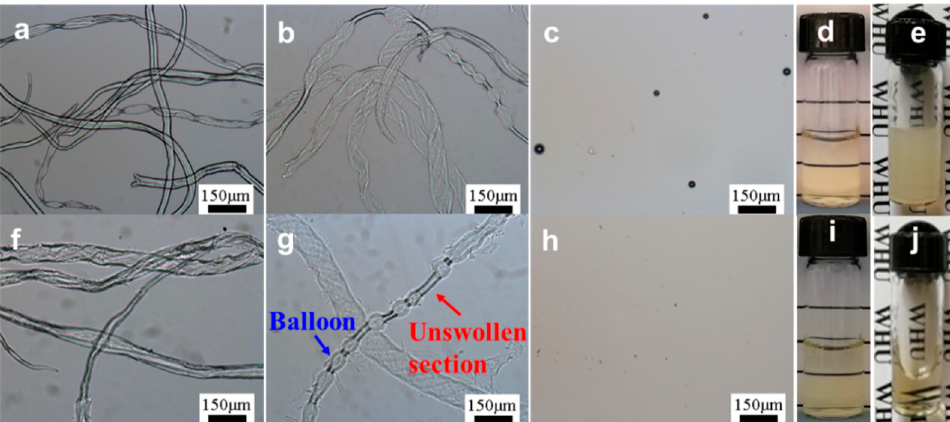
Figure 1. Optical microscopic observation of cellulose carbamate (CC) dissolving process in ( a – e ) 7 wt% NaOH and ( f – j ) 7 wt% NaOH/1.6 wt% ZnO aqueous solutions at − 24 ◦ C for different duration times: ( a , f ) 0 min; ( b , g ) 5 min; ( c , h ) 10 min. ( d , i ) the new CC solutions and ( e , j ) CC solutions placed at room temperature for 12 h.